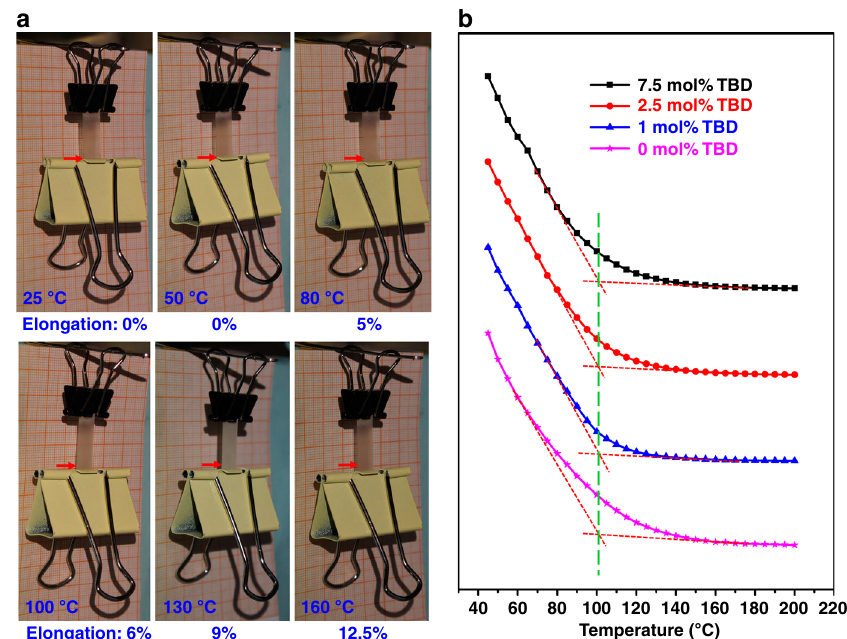
Fig. 3 The thermo-behavior and fl uorescence intensity plots with different catalyst loading of epoxy vitrimers. a Creep experiment of epoxy vitrimer at a serial of temperatures (25, 50, 80, 100, 130, and 160 °C) for 10 min, respectively. The length of them increased 0, 0, 5, 6, 9, and 12.5% at 25, 50, 80, 100, 130, and 160 °C. respectively. b The fl uorescence intensity plots of 1 wt% TPE-doped epoxy vitrimer with different TBD catalyst loadings (7.5, 2.5, 1, and 0 mol% to the COOH) at a series of temperature at 470 nm (Excitation: 365 nm). All the fl uorescence intensities are normalized to 45 °C